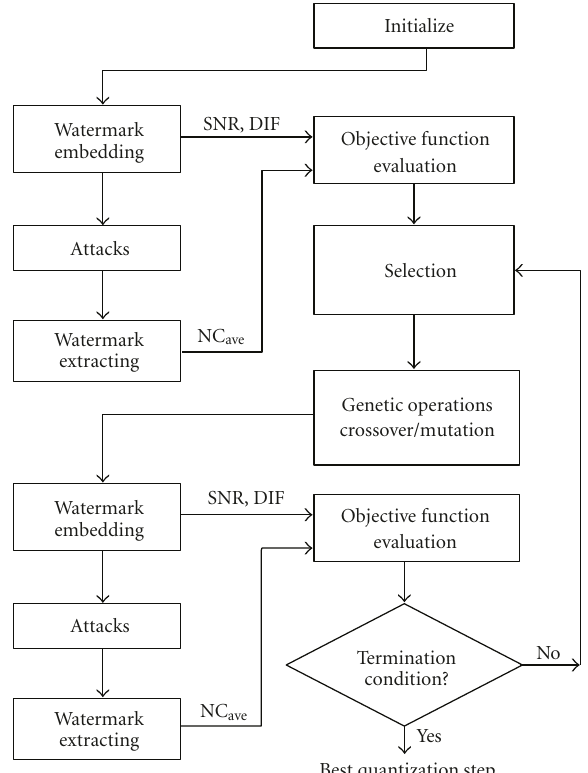
Figure 6: Optimization diagram for digital audio watermarking using genetic algorithm.